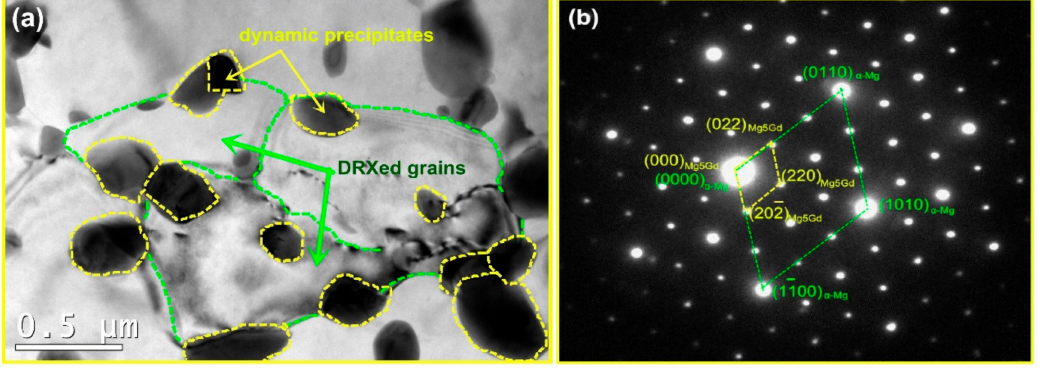
Figure 4. The TEM image of DRXed region ( a ) and the selected area electron diffraction (SAED) pattern ( b